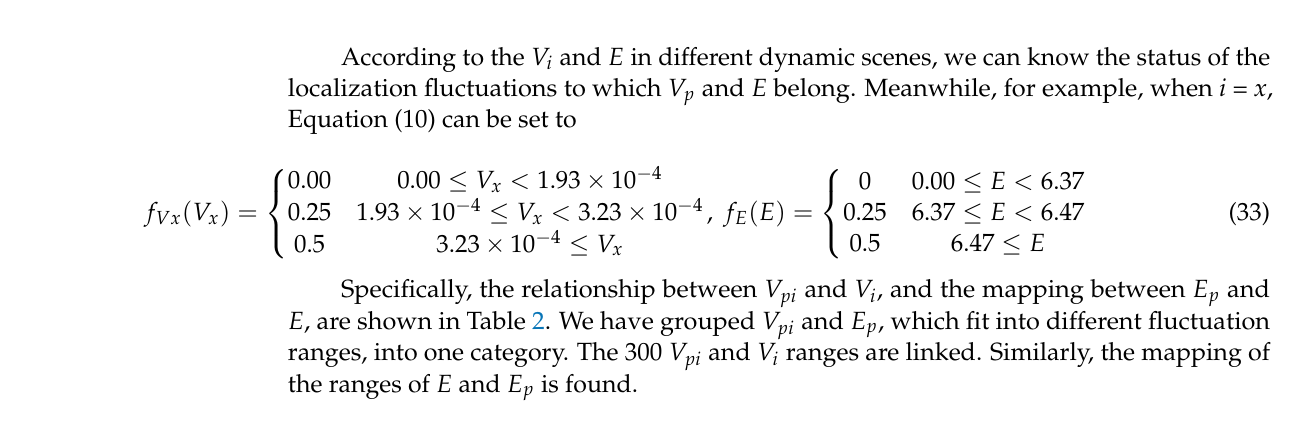
Table 2. The results of V pi and E p in different